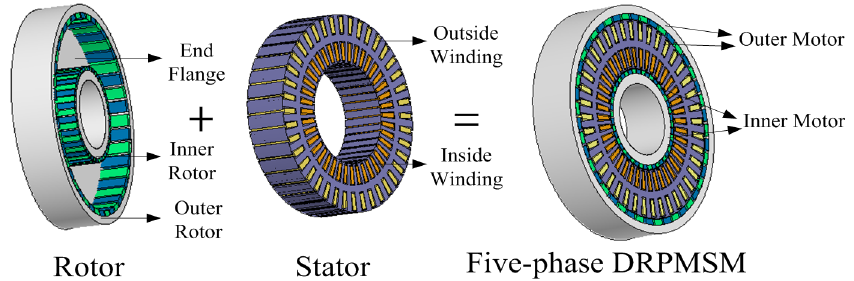
Figure 1. The structure of the five-phase dual-rotor permanent-magnet synchronous motor